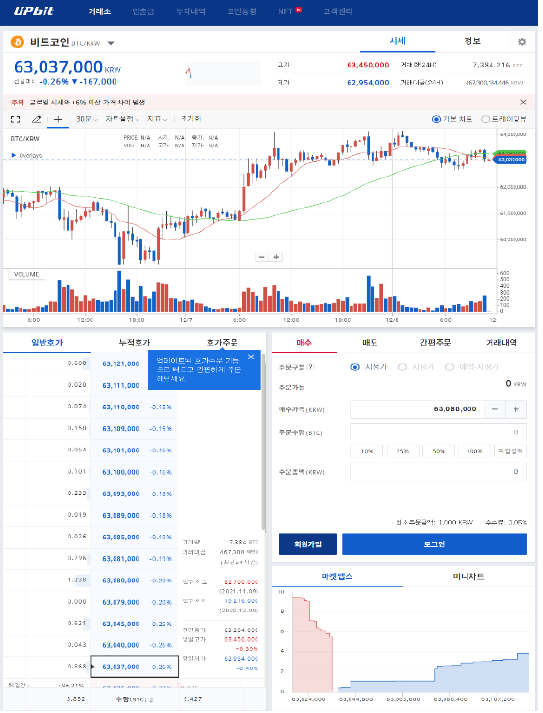
Figure 2. Interface screen of Upbit, one of the Korean cryptocurrency exchange markets.